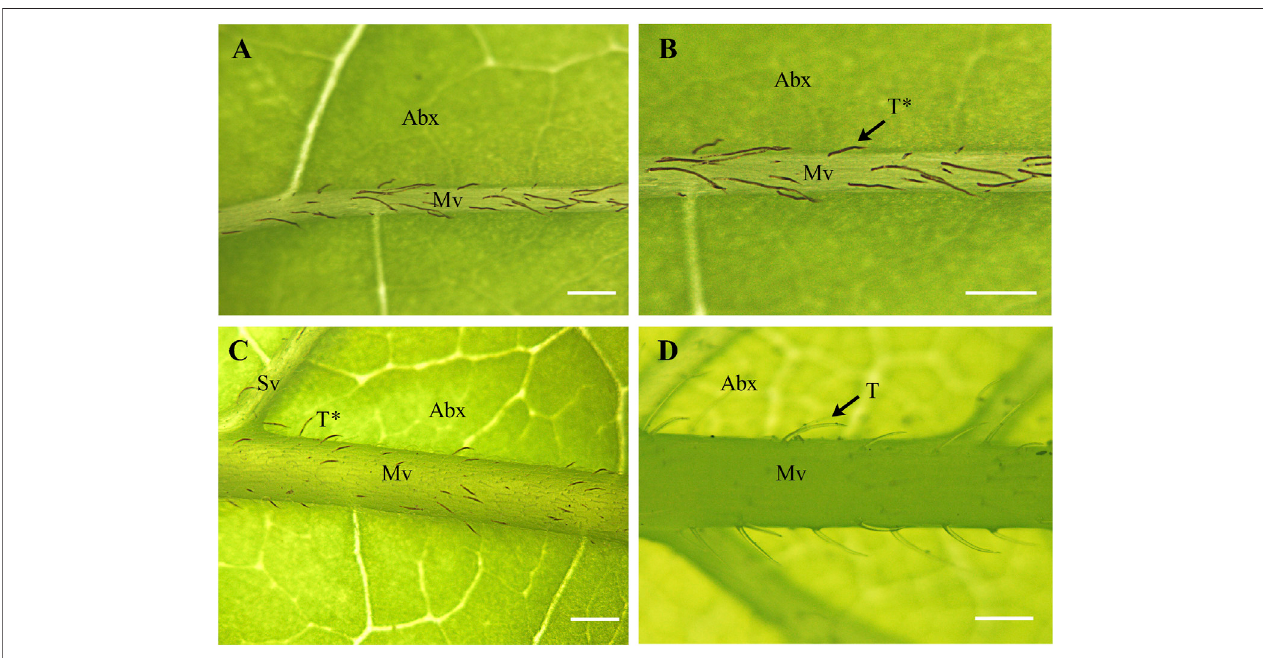
FIGURE 6 | Structure and distribution of unicellular trichomes in Calycanthaceae. (A,B) Calycanthus chinenses (C) Calycanthus fl oridus ; and (D) Chimonanthus praecox . Abx, abaxial; Mv, midvein; Sv, secondary vein; T, transparent trichomes; T * , dark brownish (non-transparent) trichomes. Scale bars (A – D) (cid:1) 200 µm. Abaxial leaf surfaces were examined using a Nikon SMZ800